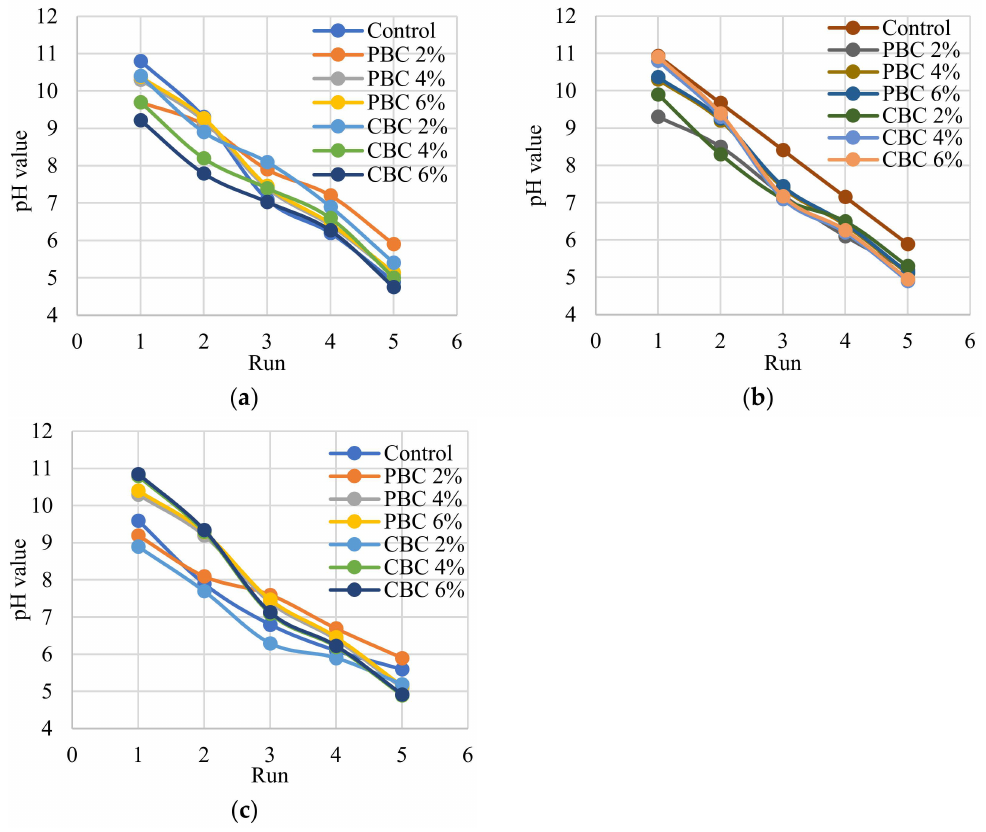
Figure 10. Results of the pH values in the progressive TCLP tests of the different concrete mixtures at different ages: ( a ) 1 day, ( b ) 14 days, and ( c ) 28